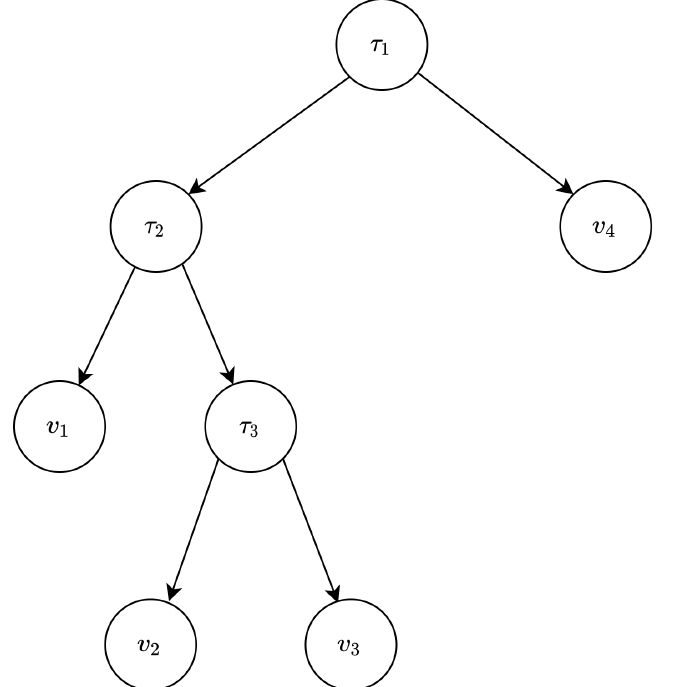
Figure 4. Decision tree with three internal nodes containing threshold value τ i and four leaf nodes containing classification result v i